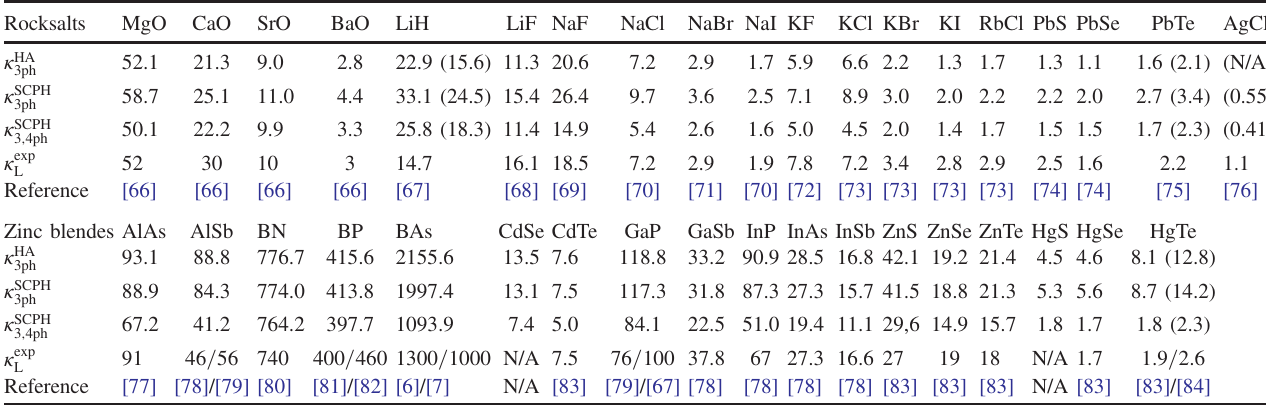
TABLE I. Calculated lattice thermal conductivities in units of W = ð m · K Þ using various levels of theory, namely, κ HA 3 κ SCPH 3 ; 4 ph , for selected binary compounds in rocksalt and zinc blende structures compared with experimental values. All theoretical values are calculated at 300 K using the PBE functional, except those values in parentheses for PbTe, AgCl, and HgTe, which are calculated using the PBEsol functional. Thermal expansion is also included (using experimental lattice parameters at 300 K) in the case of LiH, PbTe, and AgCl, as they display much larger thermal expansion than that of HgTe. The absence of κ HA 3 imaginary frequencies in harmonic phonons. Note that the ground-state structures of HgS and CdSe are not zinc blende, and hence no experimental κ is available. We include hypothetical zinc blende HgS and CdSe to compare the trend across S = Se = Te L